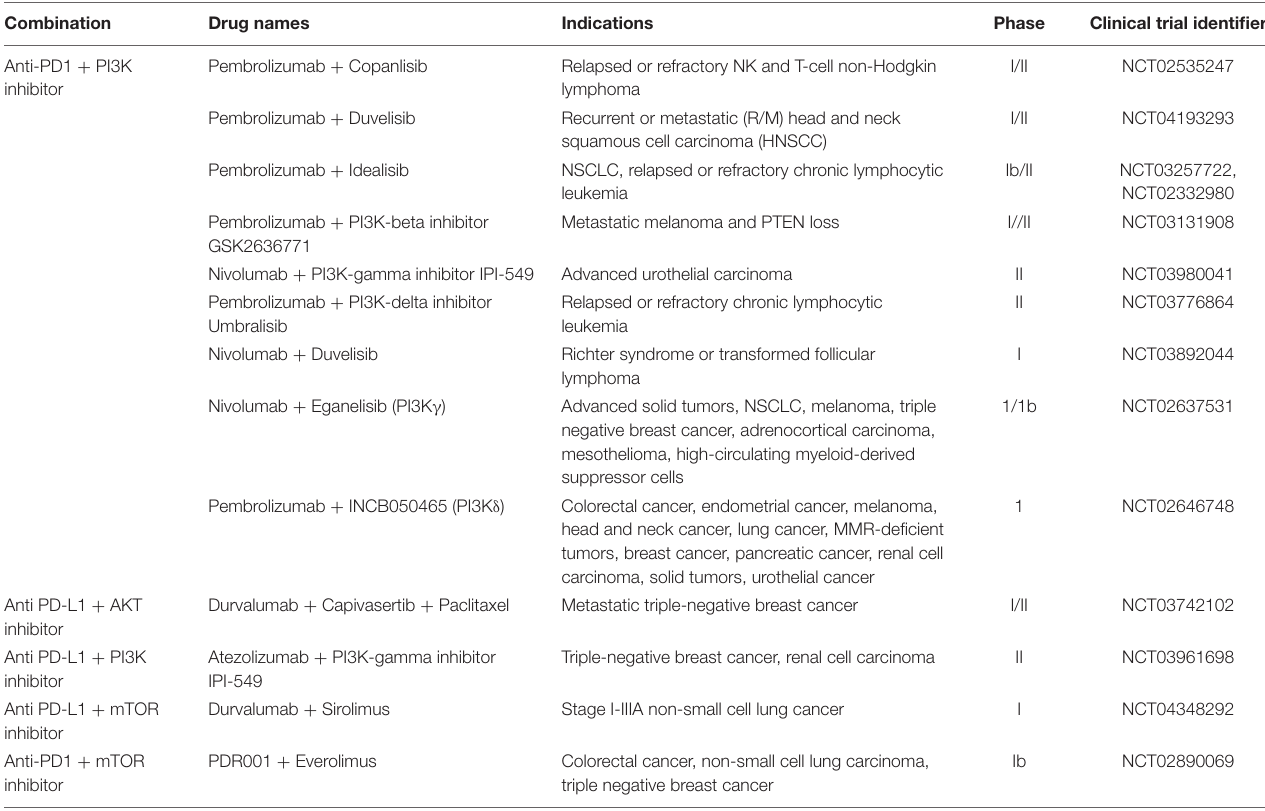
TABLE 2 | Ongoing clinical trials combining immune checkpoint inhibitors with inhibitors of the PI3K/AKT/mTOR